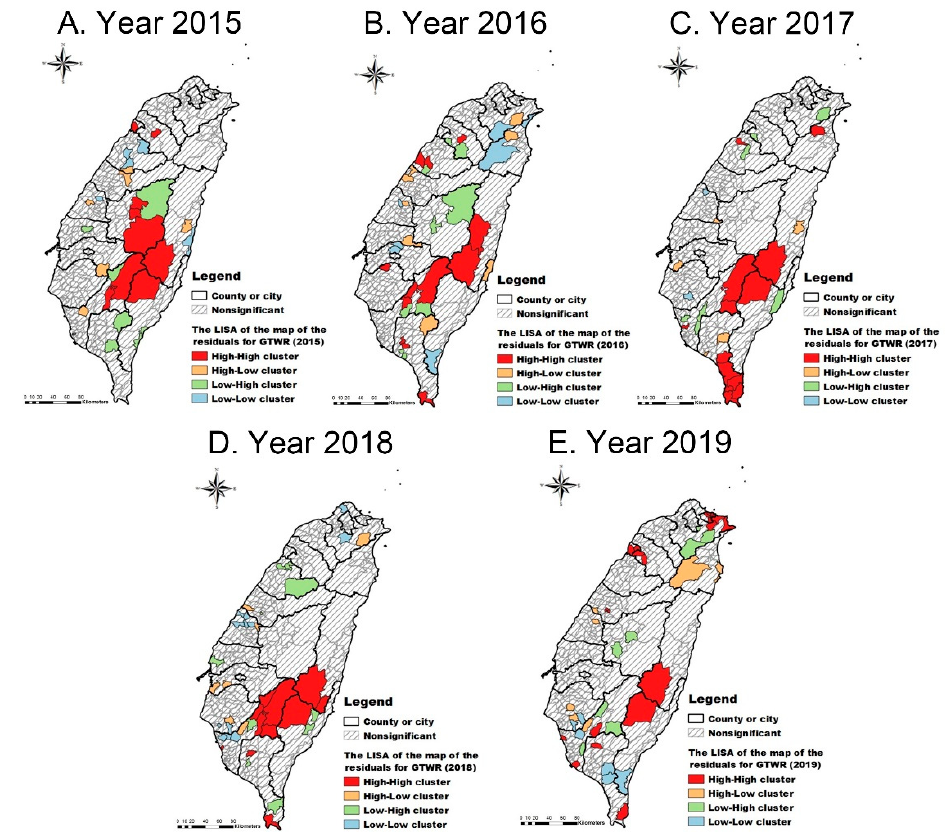
Figure 3. The local indicator of spatial autocorrelation (LISA) cluster maps of the residuals from the GTWR (2015–2019). The black line indicates the boundary of a county or city. The grey line indicates the boundary of a township/neighbourhood in a county or city. The grey slashes indicate no cluster pattern of the residuals.